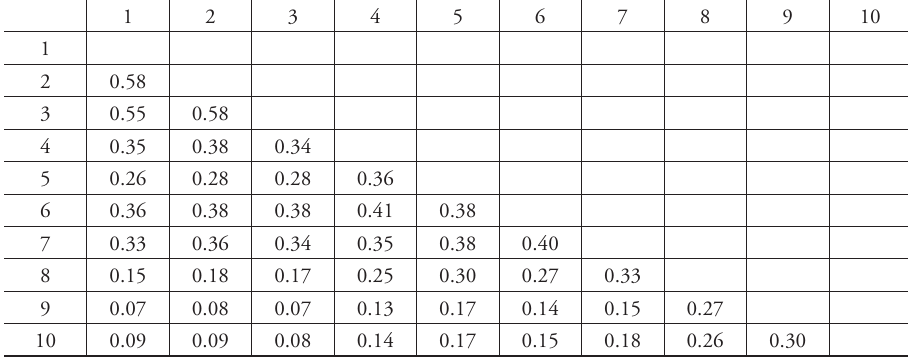
Table 2. Jaccard similarity indices for pairwise comparisons of geographical regions using all Xinjiang seed plant species. Regional division of Xinjiang is shown in Fig. 1.